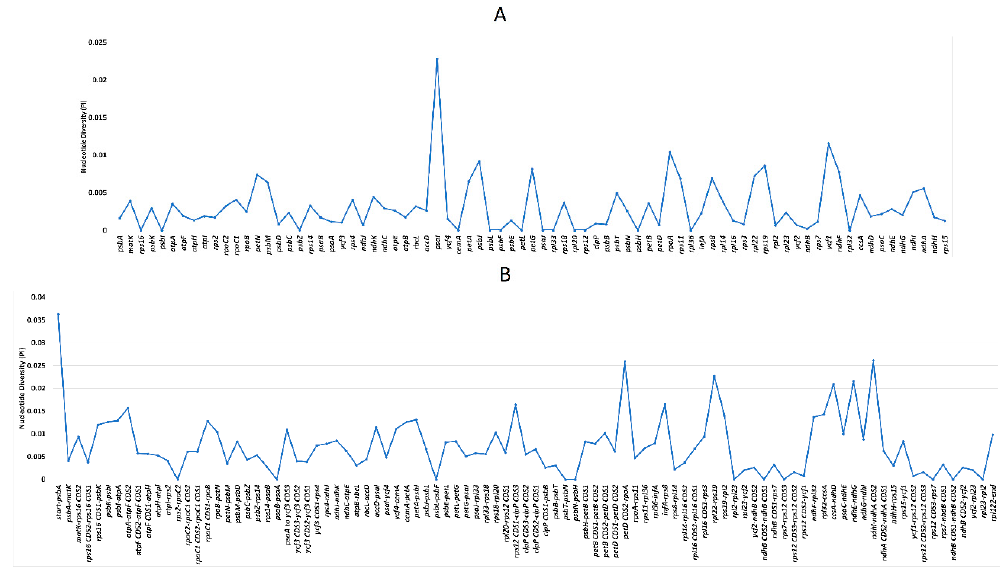
Figure 7. Nucleotide diversity (Pi) of various regions in Bougainvillea chloroplast genomes. ( A ) Nucleotide diversity values in the protein-coding regions. ( B ) Nucleotide diversity values in the non-coding regions.